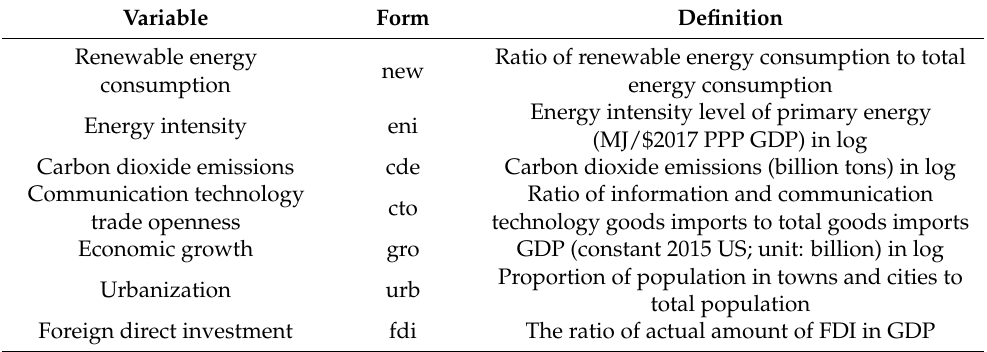
Table 1. Results of variable